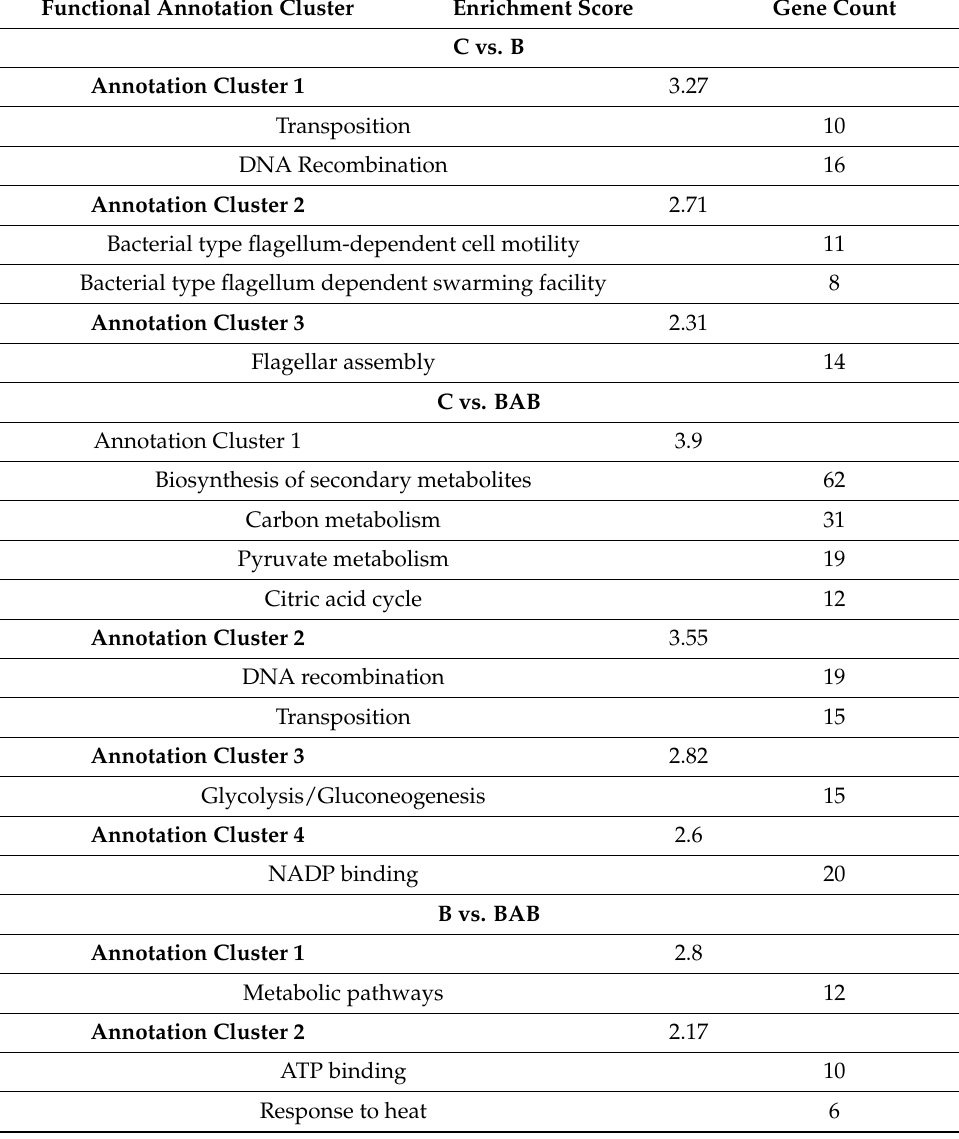
Table 1. Summary of functional annotation clustering analysis by DAVID tools. Clusters ES threshold was set to 2 and gene count ≥ 4 was only represented in